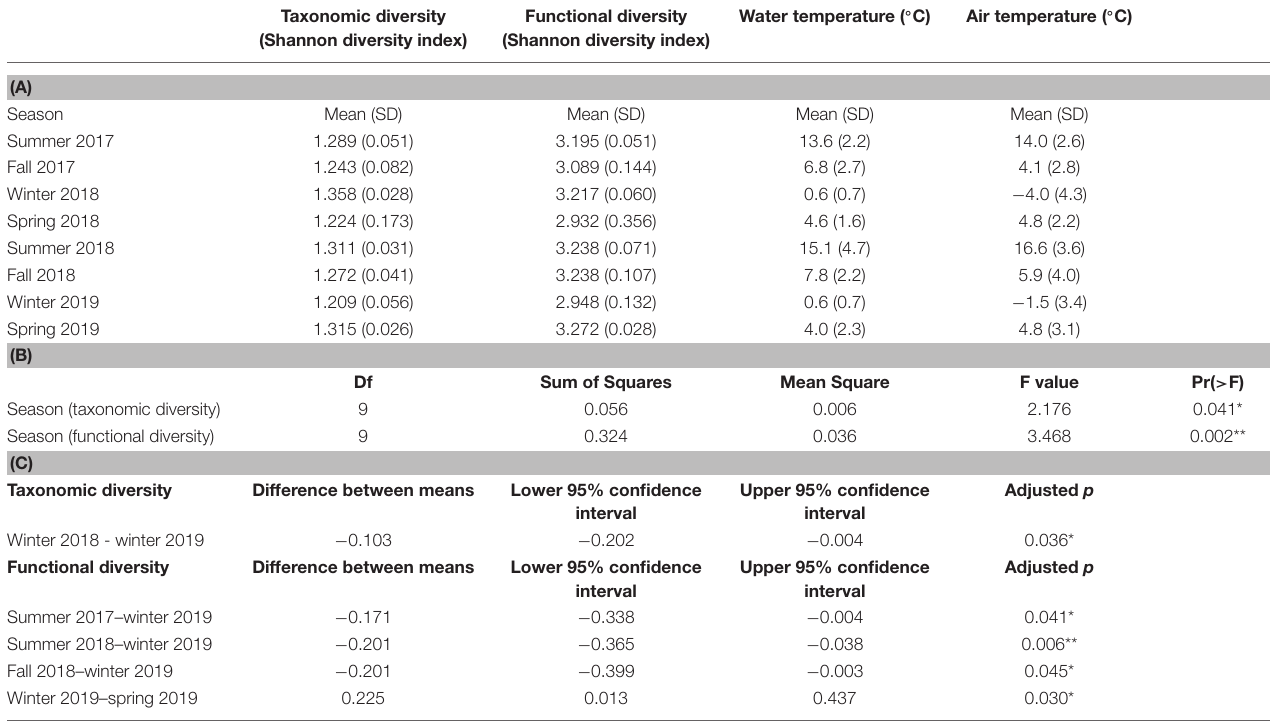
TABLE 2 | (A) Mean and standard deviation for taxonomic and functional diversity (Shannon diversity index), water temperature and air temperature during seasons; (B) Results of the one-way ANOVA test to analyze the significance of the season for taxonomic and functional diversity; (C) Results of the Tukey Honest Significant Differences test to analyze pairwise differences between diversities of all seasons.